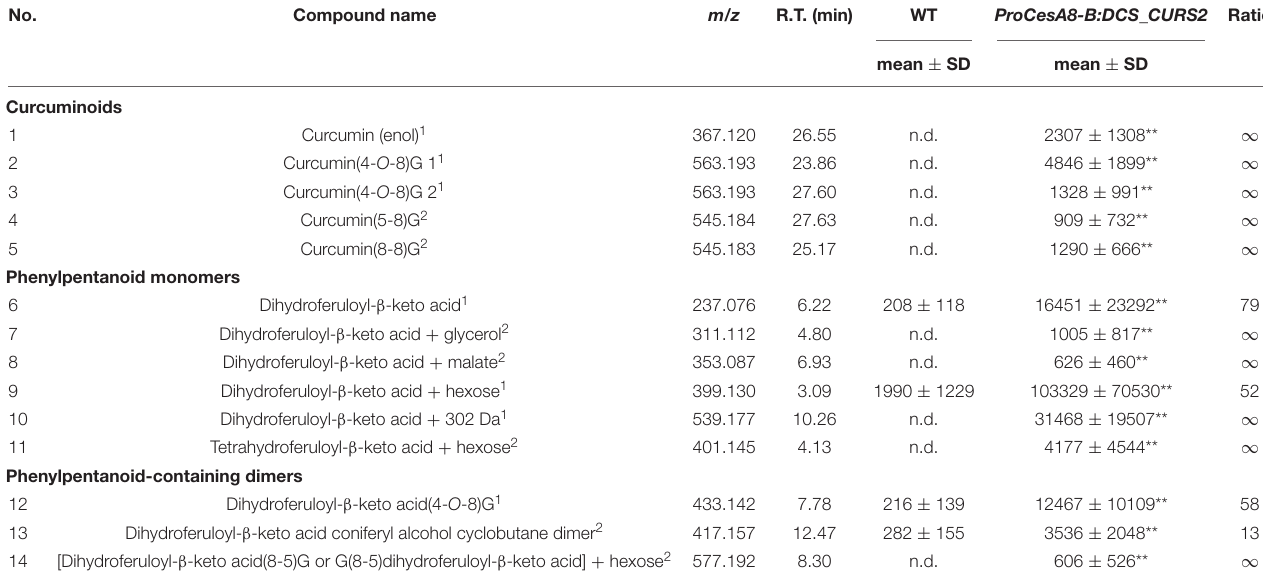
TABLE 1 | Targeted analysis of phenolic metabolites in ProCesA8-B:DCS_CURS2 poplar stems. No.